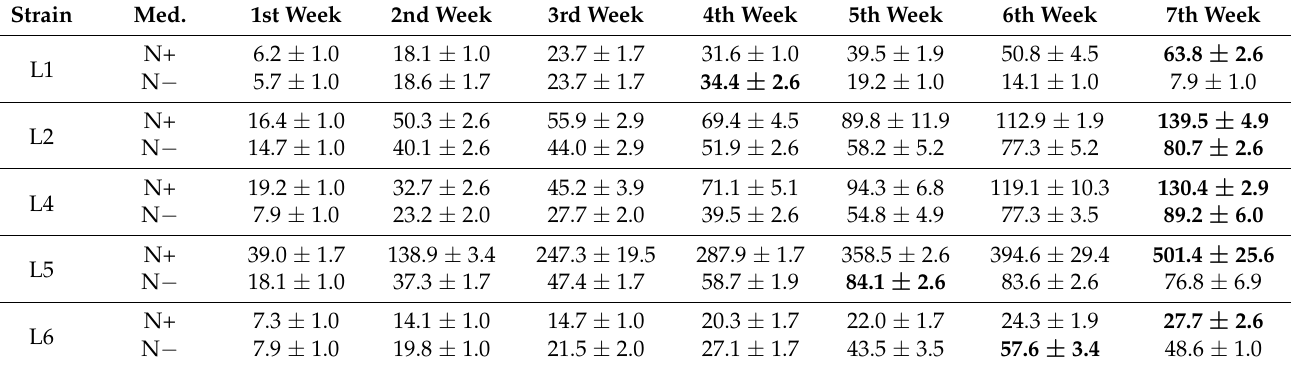
Table 2. Biomass production (mg/L) by isolated cyanobacterial strains. The biomass production by the strains cultivated in BG11 N+ and BG11 N − media was measured at seven-day intervals. The highest biomass produced by each strain in the appropriate medium is marked with